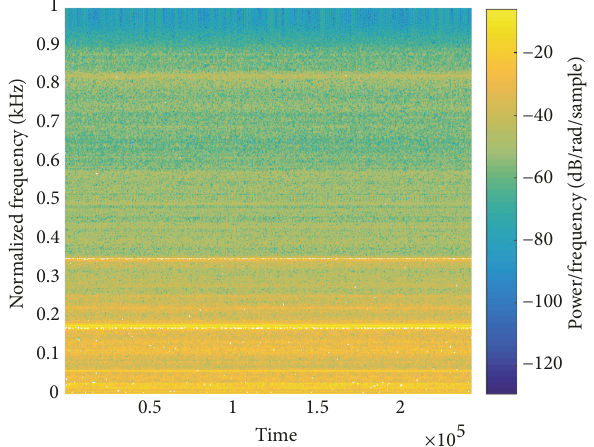
Figure 3: STFT spectrogram of baseline raw signal.